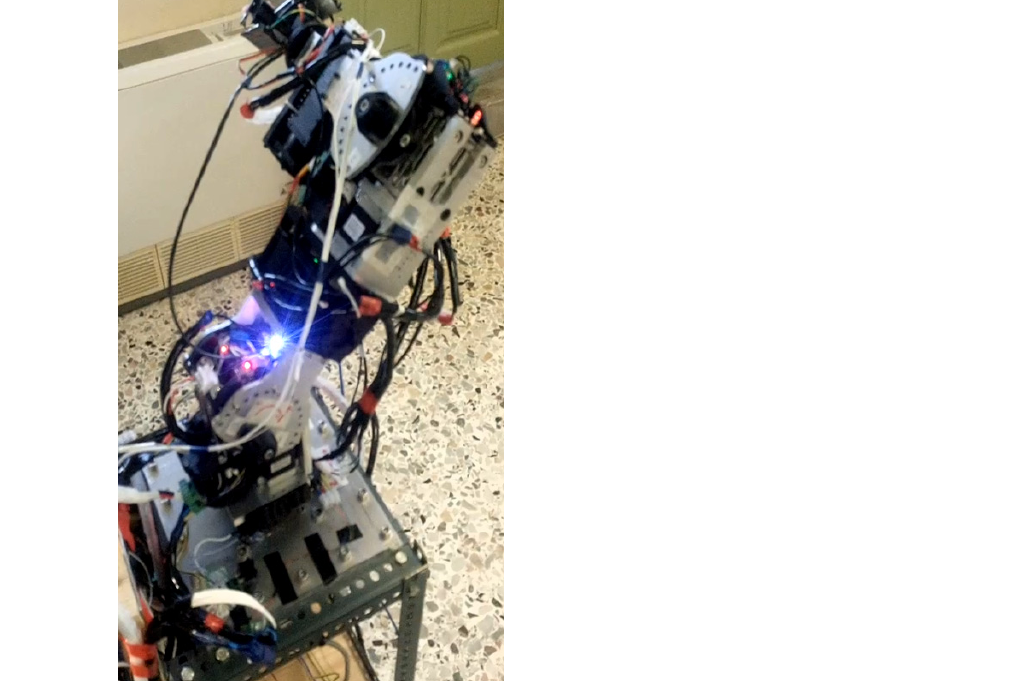
Figure 27. Optimal anatomy of the metamorphic manipulator derived under the effective mass measure for Task 4.